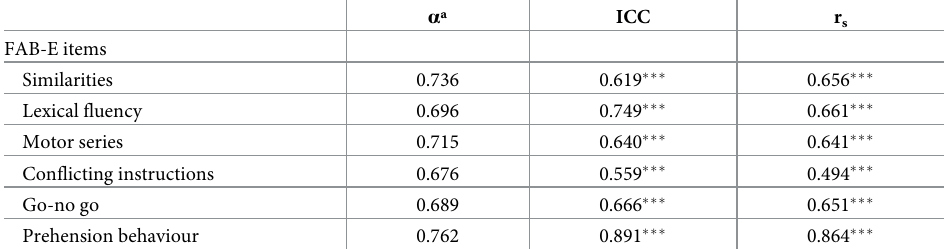
Table 2. Internal consistency and reliability measures of the FAB-E scores among PD patients (n =